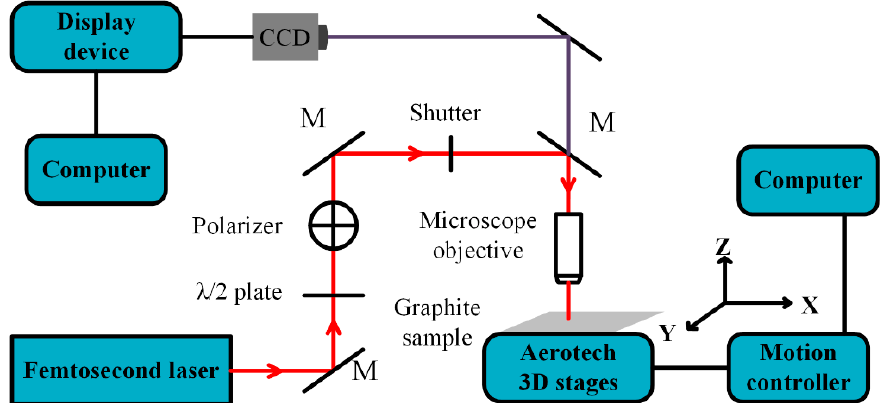
Figure 1. Schematic of the femtosecond laser processing setup for functional surface.